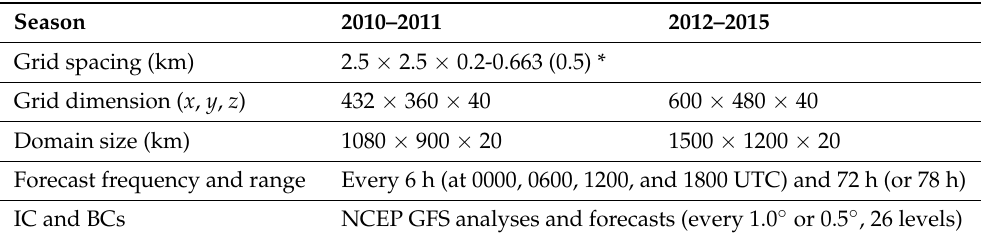
Table 1. The basic domain and configuration of the 2.5 km CReSS from 2010 to 2015.